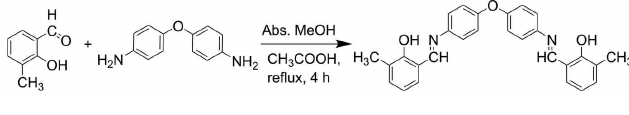
Figure 4 Reaction scheme for the synthesis of the title compound. Table 2 Experimental